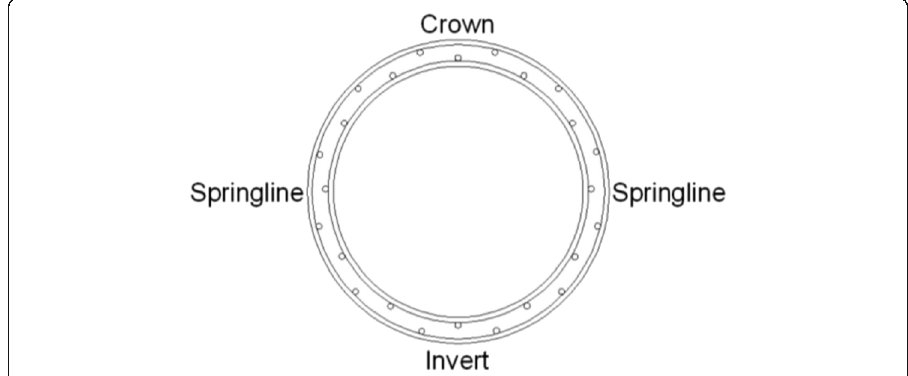
Fig. 1 Location of the crown, invert, and spring lines